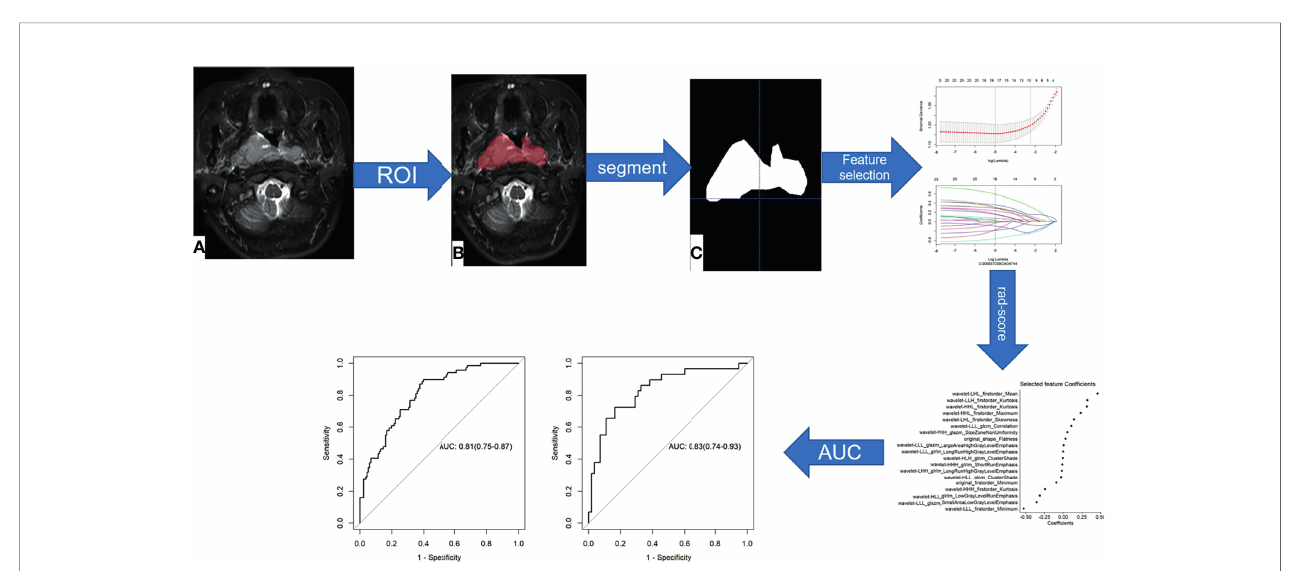
FIGURE 1 | Flow chart of radiomics feature selection and model construction. (A – C) Image segmentation is performed on MRI